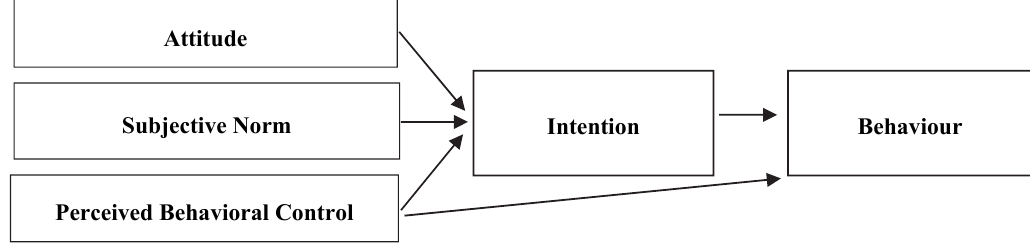
Fig. 1. The Theory of Planned Behavior (Ajzen, 1985, 1991)